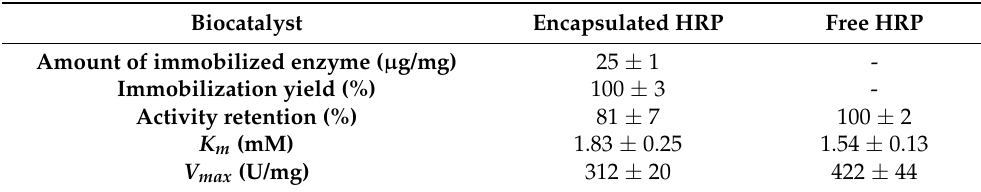
Table 1. Amount of immobilized enzymes, immobilization yield, activity retention and kinetic parameters of the free and immobilized HRP.